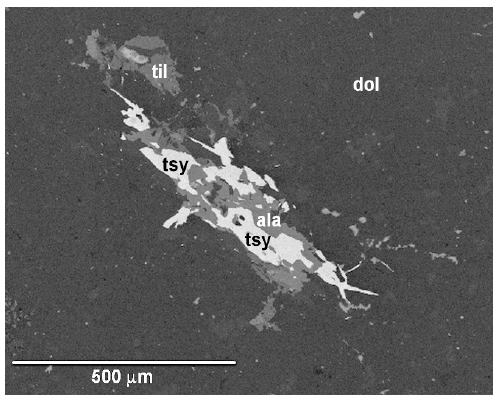
Figure 2. SEM (BSE) image of tsygankoite grain from Figure 1 shows tsygankoite (tsy) being partially replaced by alabandite (ala). Both minerals are associated with tilasite (til) and are embedded in a dolomite-calcite. Polished section.